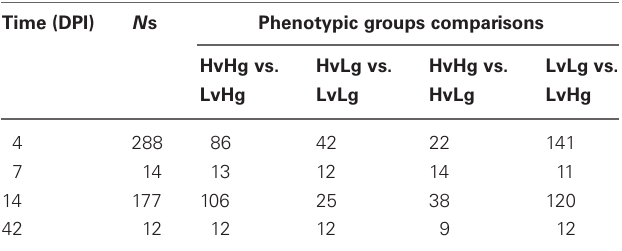
Table 1 | Number of putatively differentially expressed